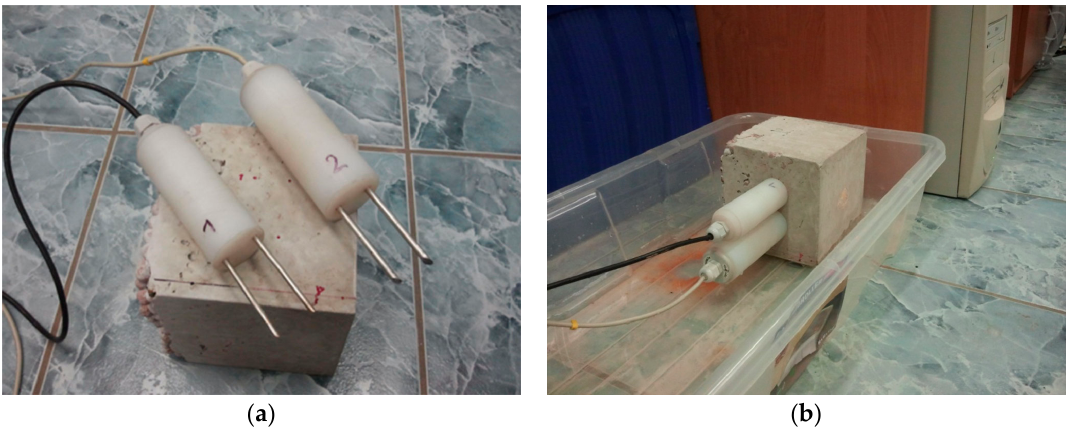
Figure 1. Determination of the capillary uptake process: ( a ) presentation of the sample and the modified probes; and ( b ) measuring setup ready for the experiment.